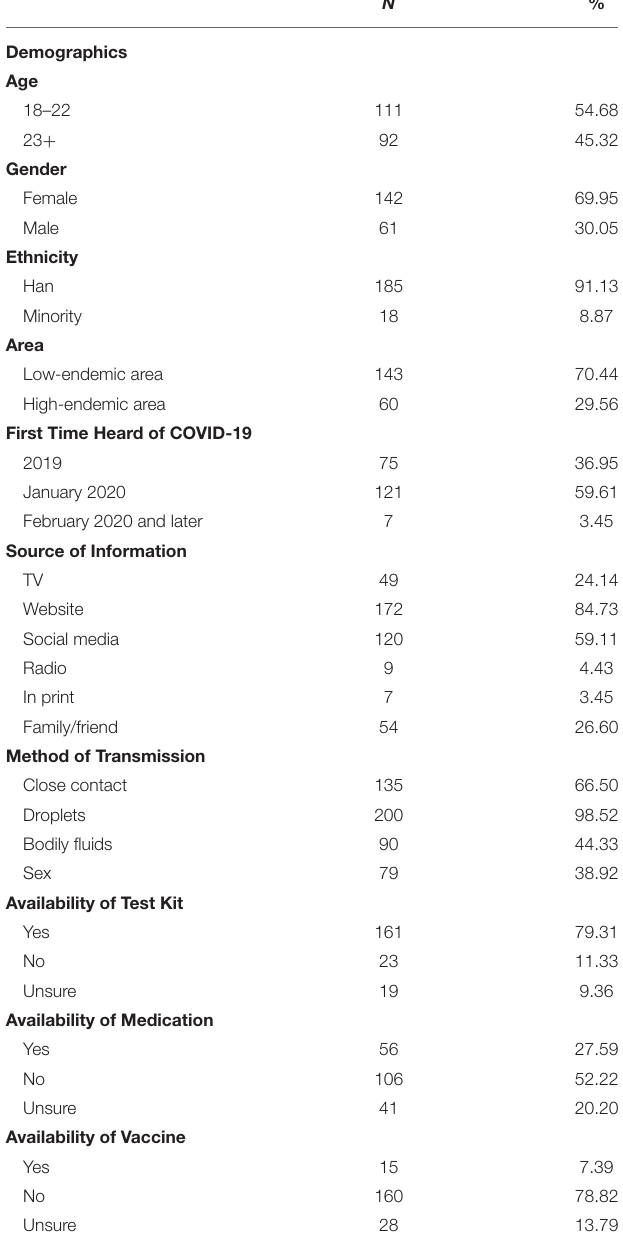
TABLE 1 | Characteristics and knowledge of study respondents ( N =